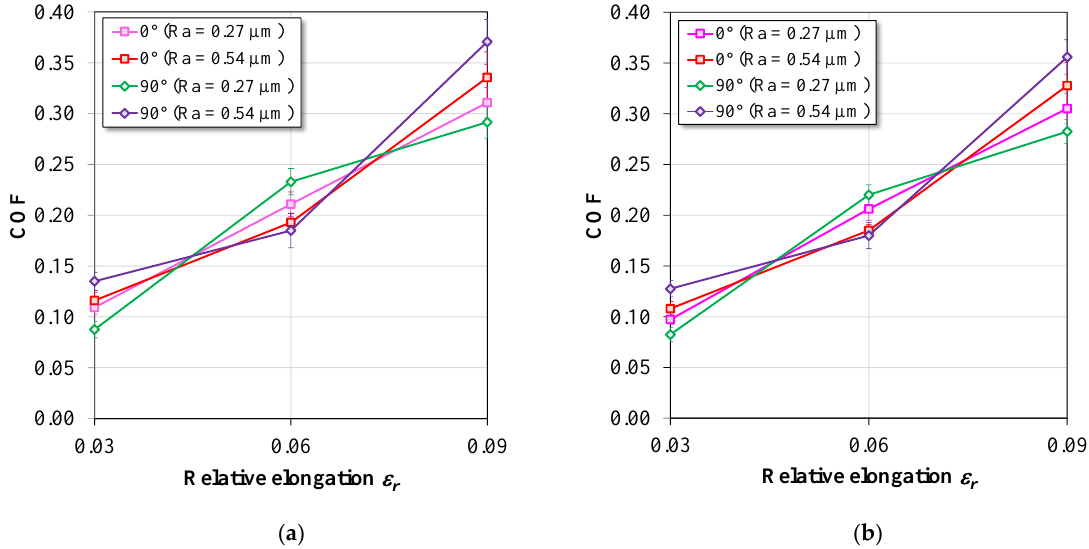
12 of 20 Figure 9. ( a ) Friction characteristic curve with two stages of friction (BUT test); ( b ) Image showing the change from scratching to severe adhesive wear; ( c ) Specimen with a high degree of discolora- tion and galling. Figures 10 and 11 show the variation in the COF obtained from the different forma- bility tests as a function of the relative elongation 𝜀 𝑟 , strip orientation, pin roughness, and lubrication conditions. In general, the COF value increases with pin roughness under dry and lubricated conditions in both formability tests. Simultaneously, the amount of lubri- cant used reduces the COF value. In lubricated contacts, the intermolecular forces between the tribosurfaces tend to be reduced, causing attenuation in the frictional resistance. The